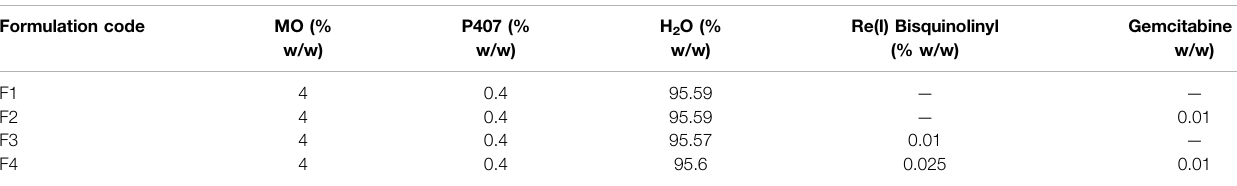
TABLE 1 | Compositions of F1, F2, F3, and F4 Formulation